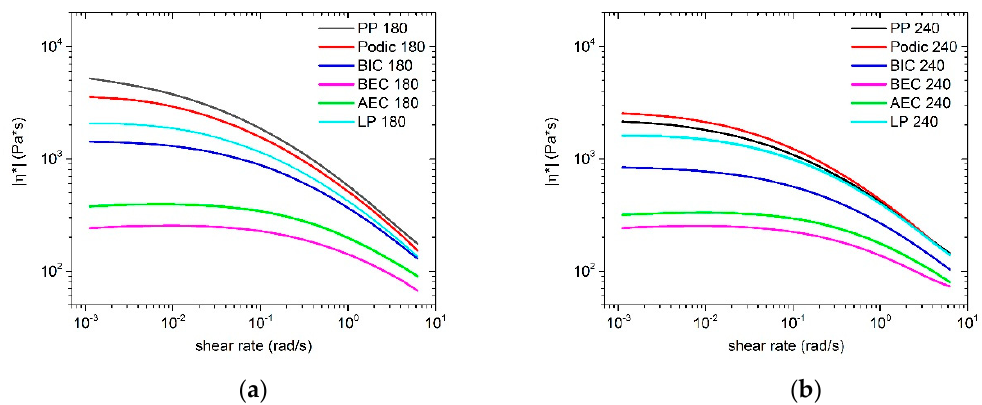
Figure 4. Complex viscosity versus shear rate of samples extruded at ( a ) 180 °C; ( b ) 240 °C; measured at 230 °C.